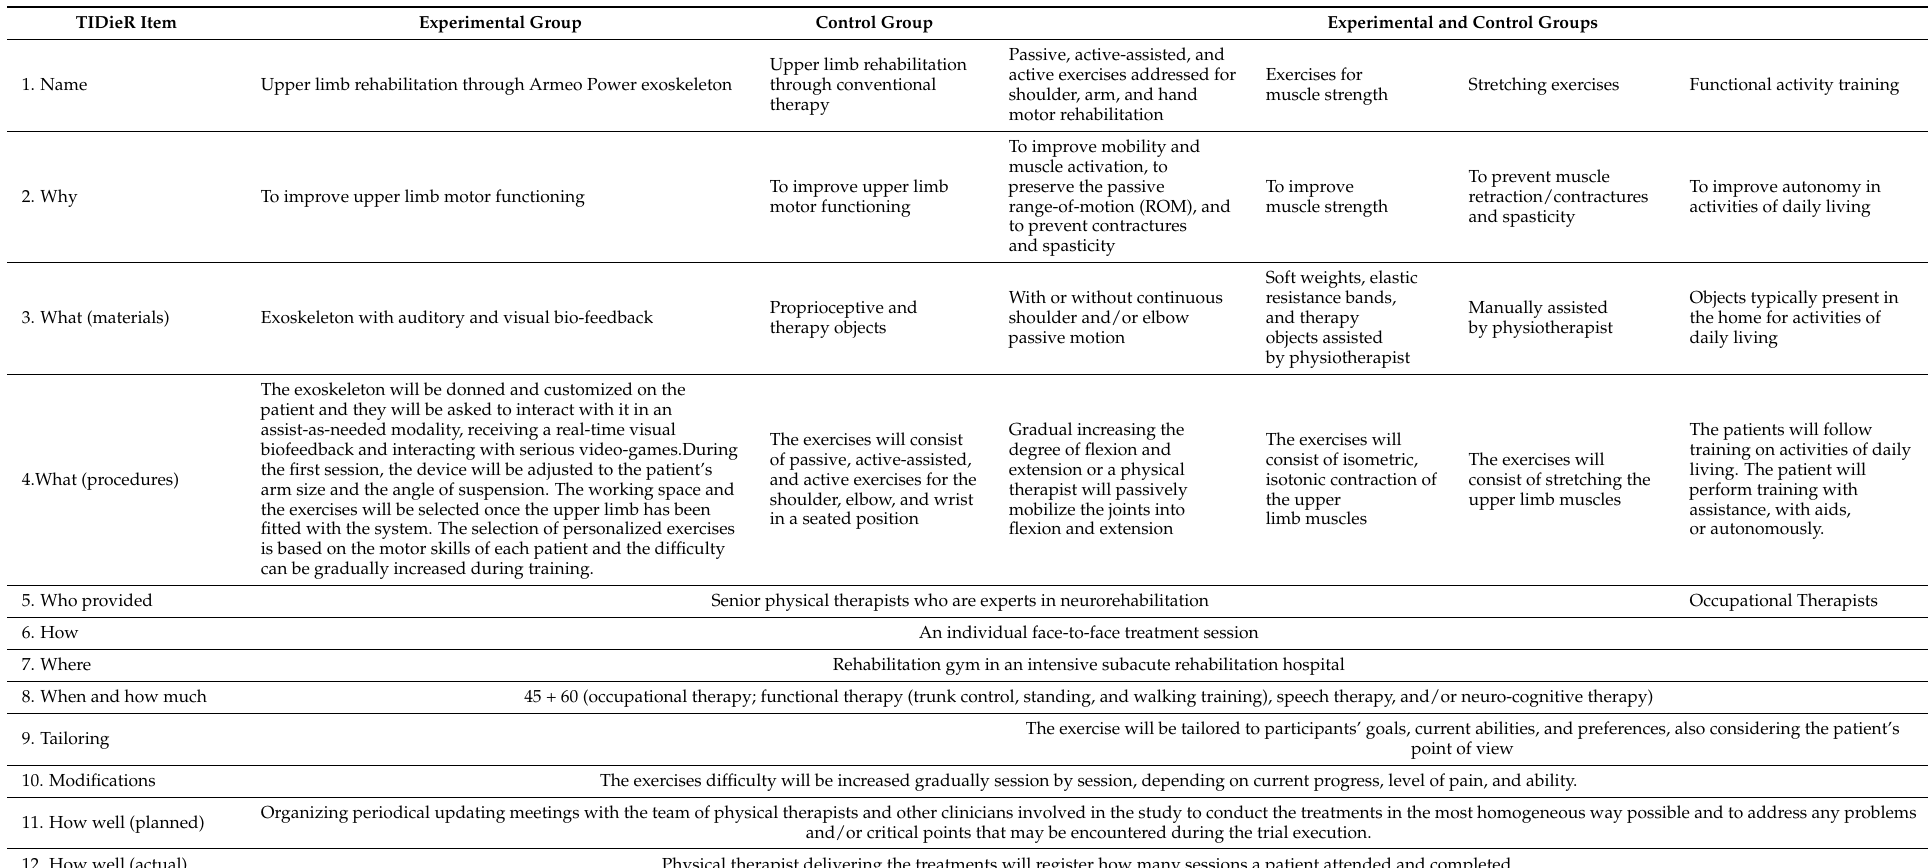
Table 1. Overview of an intervention session in the experimental and control groups according to the Template for Intervention Description and Replication (TIDieR) checklist and guide. Both groups will receive 25 sessions of rehabilitation treatment for three weeks (5